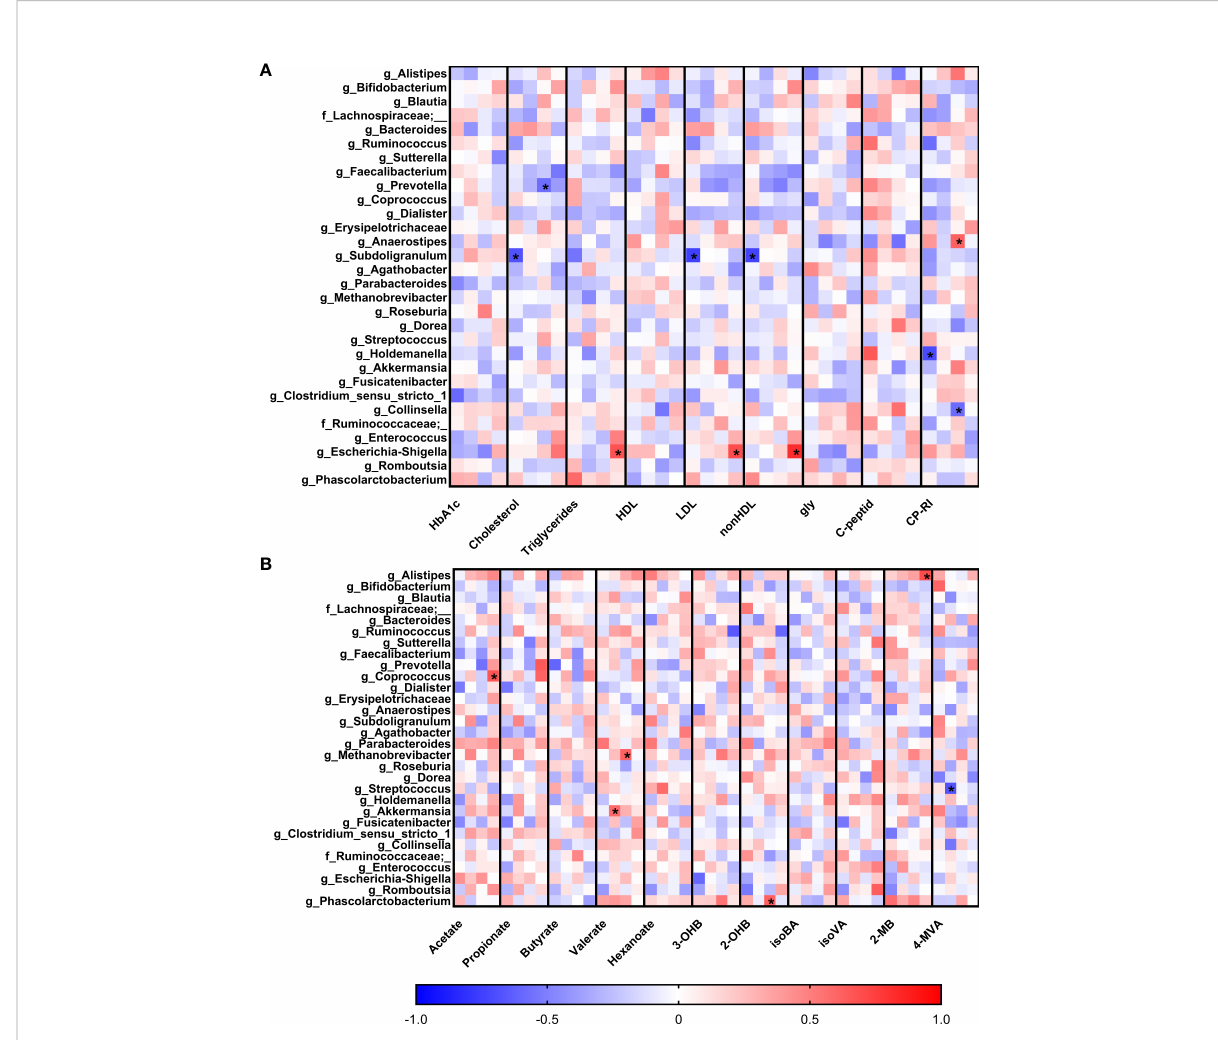
FIGURE 4 Correlations of serum biochemical parameters (A) and levels of short-chain fatty acids (B) with bacterial abundances. Within each column, the subcolumns are in order: healthy pregnant women, GDM1, GDM2 and GDM3. The strength and polarity of correlation is color-coded, e.g. negative correlation in shades of blue. All p-values were adjusted for multiple comparisons, p<0.001 was considered statistically signi fi cant and signi fi cant correlations were marked with the